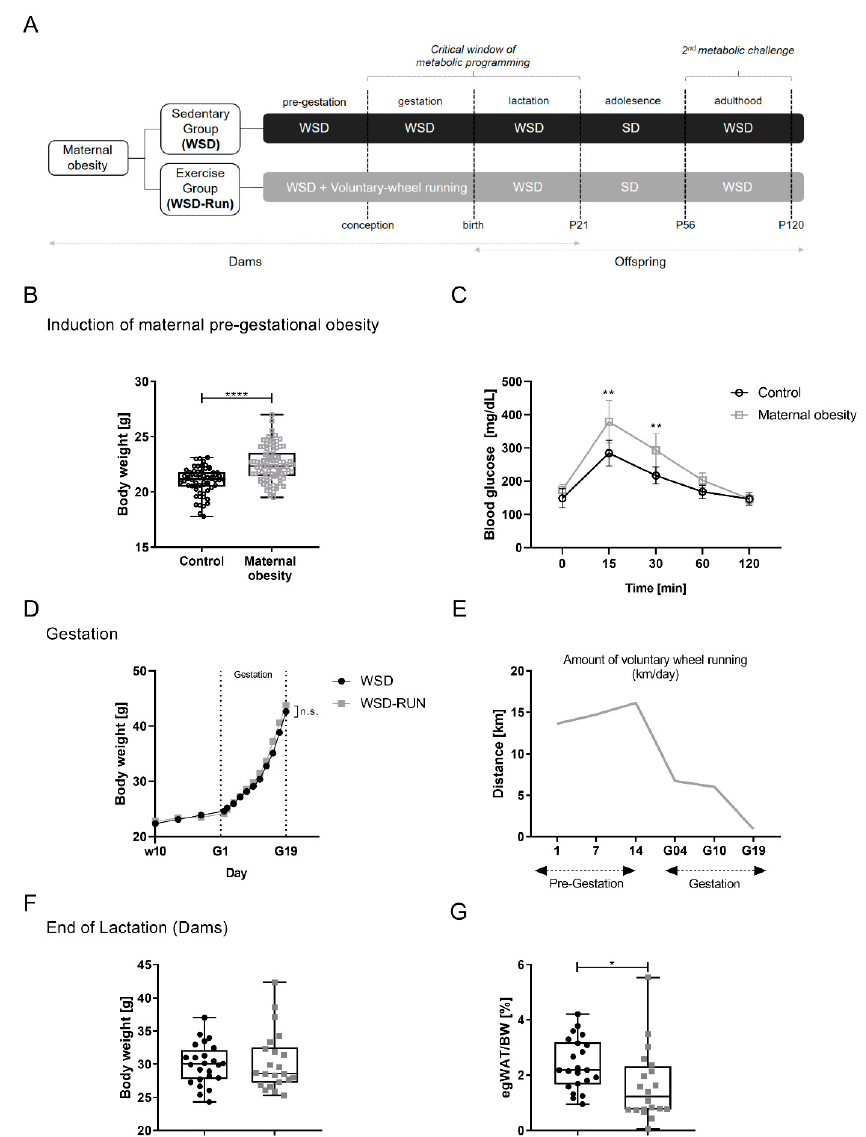
Figure 1. Maternal exercise before and during pregnancy alters the body composition of obese dams. ( A ) Experimental design: WSD, sedentary obese dams; WSD-Run, obese dams performing voluntary wheel running before and during pregnancy. ( B ) Induction of a model of maternal obesity. Female mice (n = 86) were fed an obesogenic western style diet for 8 weeks for induction of an obese phenotype and a cohort of obese dams, respectively. A separate cohort (n = 62) of female mice receiving a standard laboratory chow diet served as lean control group (Control). ( C ) Glucose tolerance was measured via intraperitoneal glucose tolerance test (ipGTT) at week 8–9 indicating altered glucose tolerance in obese dams ( n = 10/group). Thus, before subsequent division into an ‘exercise’ and ‘sedentary’ group, the maternal obesity cohort exhibited a disturbed metabolic phenotype with WSD induced obesity and impaired glucose metabolism. ( D ) Weight gain during pregnancy. ( E ) Average running distance of the exercise group (WSD-Run) before and during pregnancy in km/day. ( F ) Total body weight of dams at the end of lactation at postnatal day (P) 21 (WSD group (n = 24), WSD-Run group (n = 22)). ( G ) Epigonadal fat pad weight at P21 (WSD group (n = 22), WSD-Run group (n = 20)). Data are presented as mean ± standard deviation; * p < 0.05, ** p < 0.01, **** p < 0.0001. BW, body weight; egWAT, epigonadal white adipose tissue; p, postnatal day; WSD, western-style diet; WSD-Run, western-style diet induced obese dams performing voluntary wheel